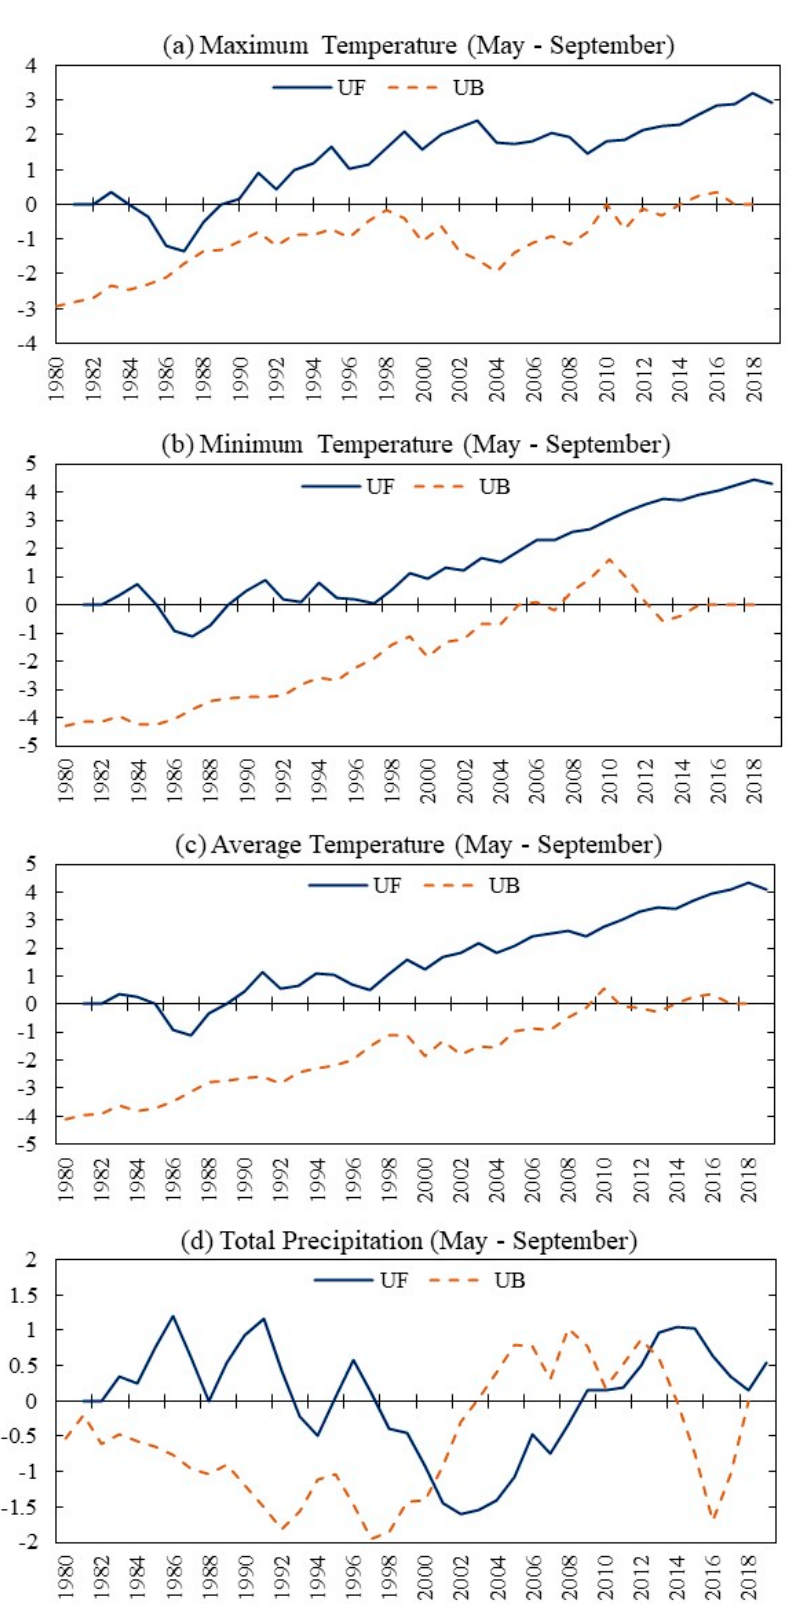
Figure 4. Sequential Mann–Kendall test statistics (UF and UB values) calculated from the ( a ) maximum temperature (average of May–September), ( b ) minimum temperature (average of May–September), ( c ) average temperature (average of May–September), and ( d ) total precipitation (total of May–September) in the 26 wild blueberry fields (shown in Figure 1) in Downeast, Maine.